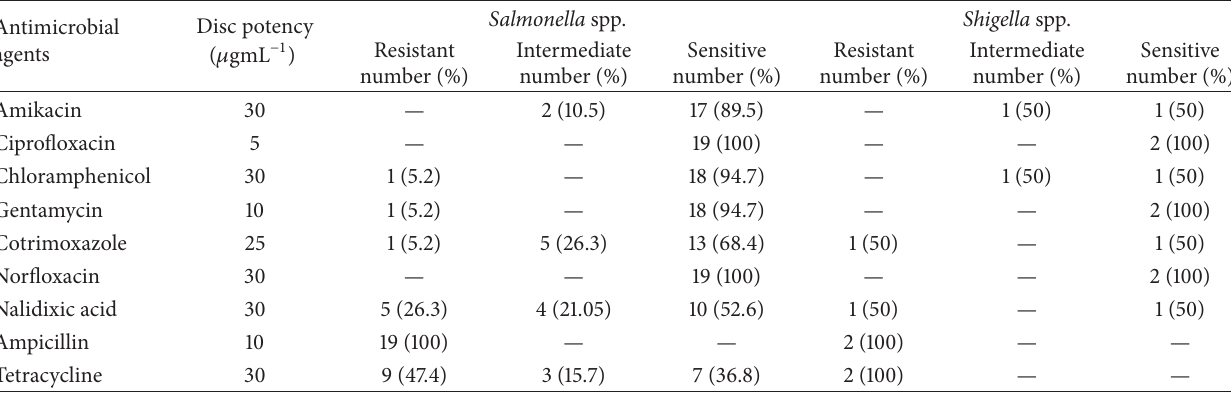
Table 3: Antimicrobial susceptibility pattern of Salmonella and Shigella spp. isolated from diarrheal outpatients in Jimma University Specialized Hospital, Jan–Mar,